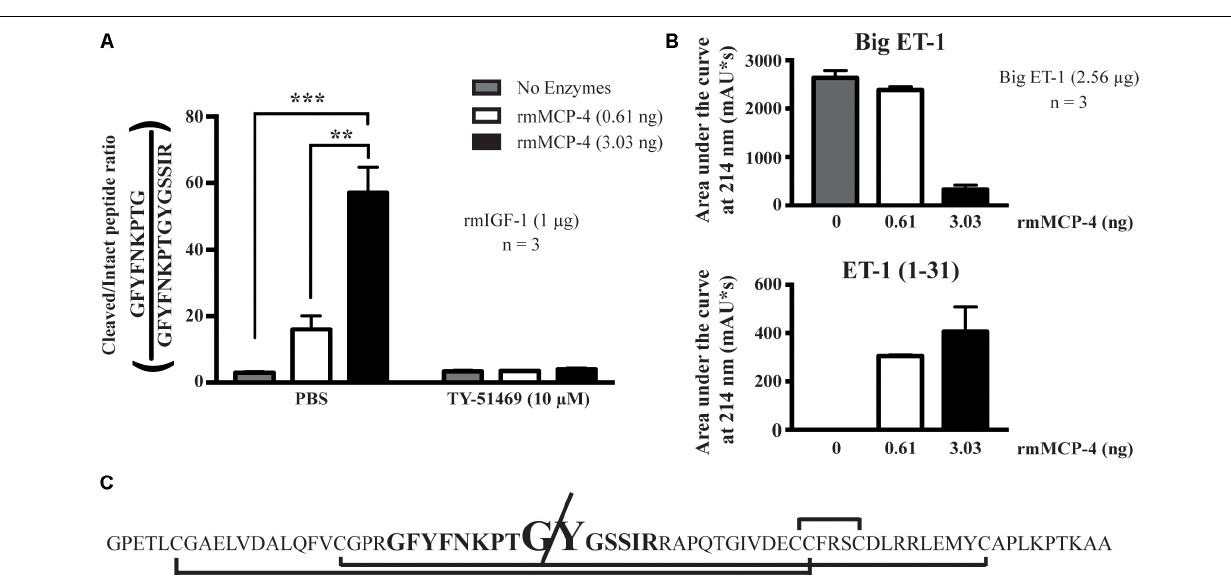
FIGURE 7 | Analysis of the in vitro hydrolysis of recombinant mouse IGF-1 (LC/MS/MS) and Big ET-1 (HPLC) by recombinant mMCP-4, with the chymase inhibitor TY-51469 (10 µ M). In (A) , the results of recombinant mMCP-4 activity on mouse IGF-1 are shown using trypsin-degradation products, with GFYFNKPTGYGSSIR coming from the complete IGF-1 sequence and GFYFNKPTGY coming from the mMCP-4-cleaved sequence. In (B) , the area under the curve (AUC) was measured for Big ET-1 and ET-1 (1–31) using HPLC at 214 nm detection. n = 3 (one-way ANOVA with multiple comparisons Holms-Šidak post-test). In (C) , the complete sequence of mouse IGF-1 is shown, with the disulfide bonds shown with brackets, the analyzed trypsin-digested product in bold and the cleavage site in increased type